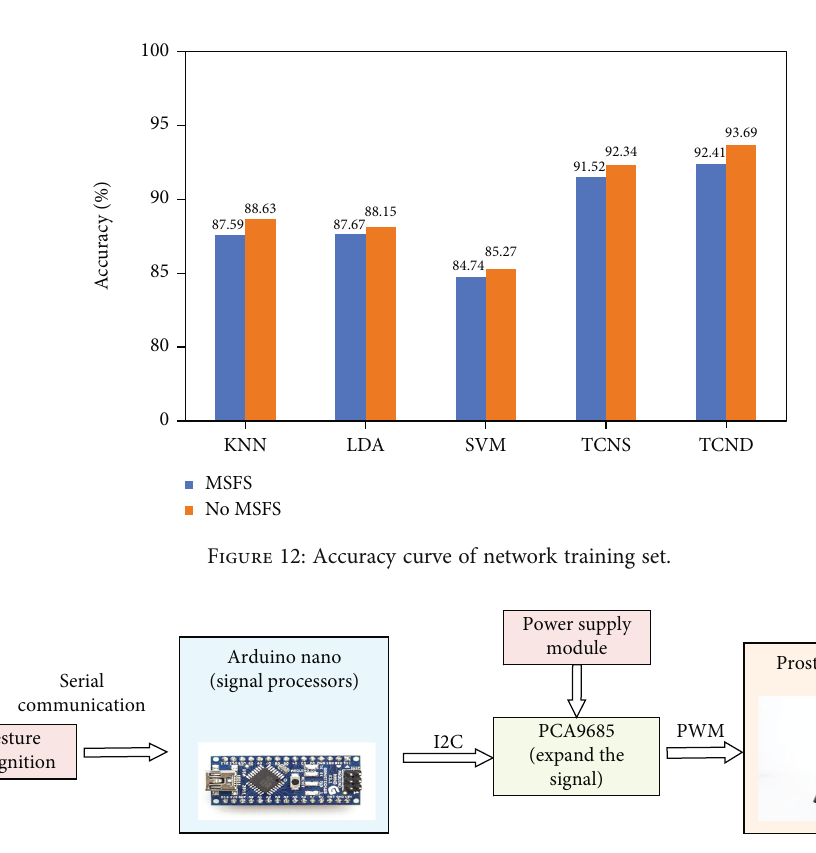
Figure 13: The hardware structure of prosthetic